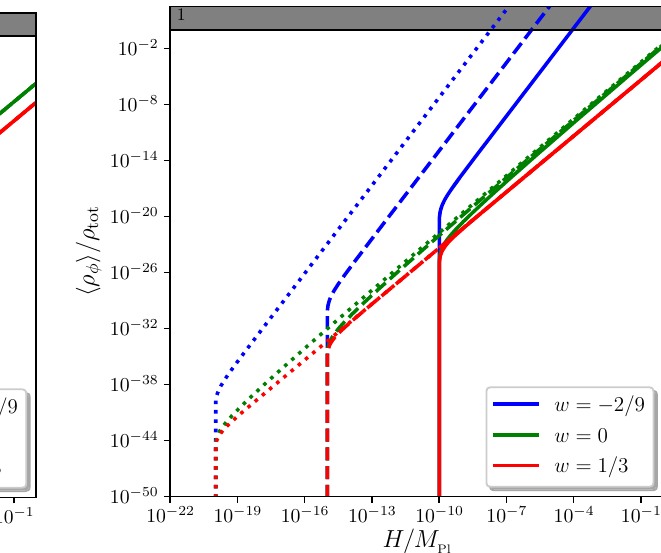
(solid lines), H in / M Pl = 10 − 15 (dashed lines) and H in / M Pl = 10 − 10 (dotted lines). The grey shaded area corresponds to (cid:8) ρ σ (cid:7) > ρ tot , where the backreaction from the shear becomes important (and where our cal- culationdoesnotapply).Rightpanel:directcontributionfromthescalar field fluctuations to the overall energy density, in the same situations as / M = 10 − 10 those shown in the left panel in Pl